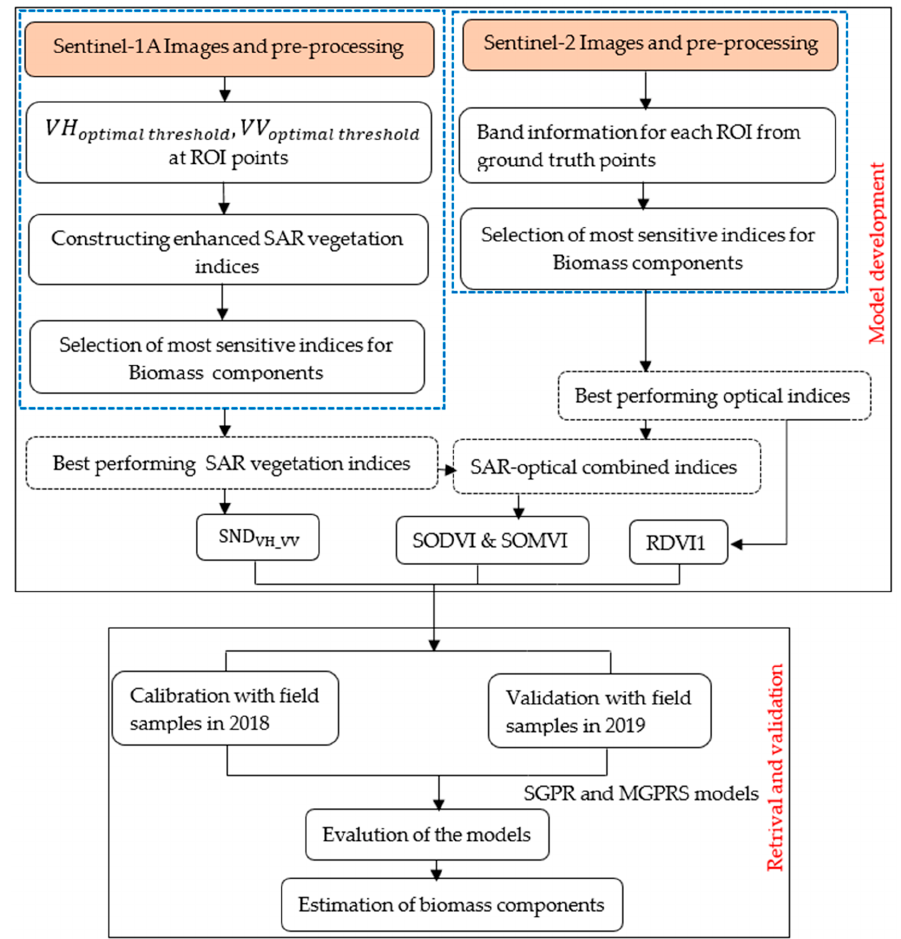
Figure 2. Flowchart of the methodology used in this study for the estimation of rice biomass components leaf biomass (LB), stem biomass (SB), leaf and stem biomass (LSB), and AGB. Table 2. Summary of selected optimal SAR and optical vegetation indices used in this study.